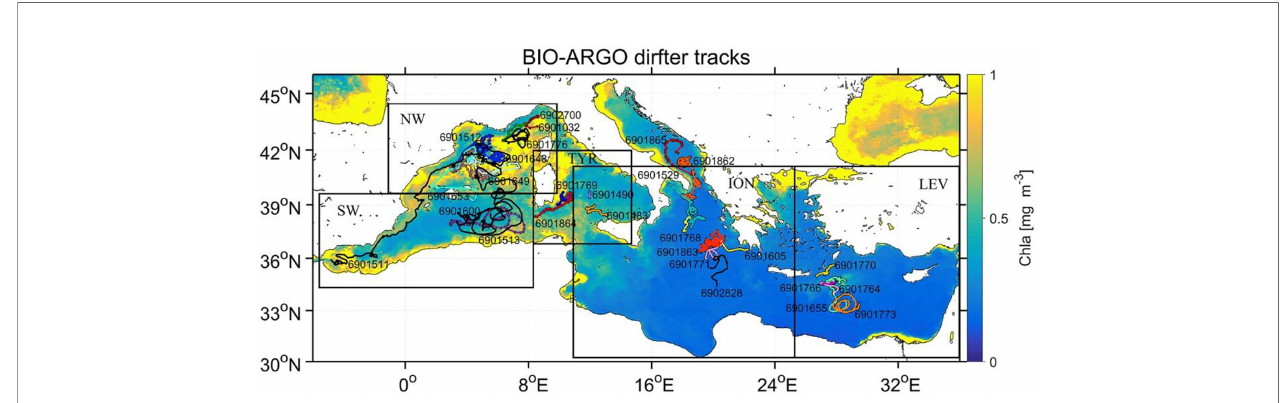
FIGURE 1 | Spatial extent of the Mediterranean Sea and subregions divided in this study. The lines in different colors indicate the trajectories of the different Bio-Argo cruises. The background colors of the Mediterranean Sea indicate the monthly average Chl-a surface concentration derived from MODIS-Aqua data in